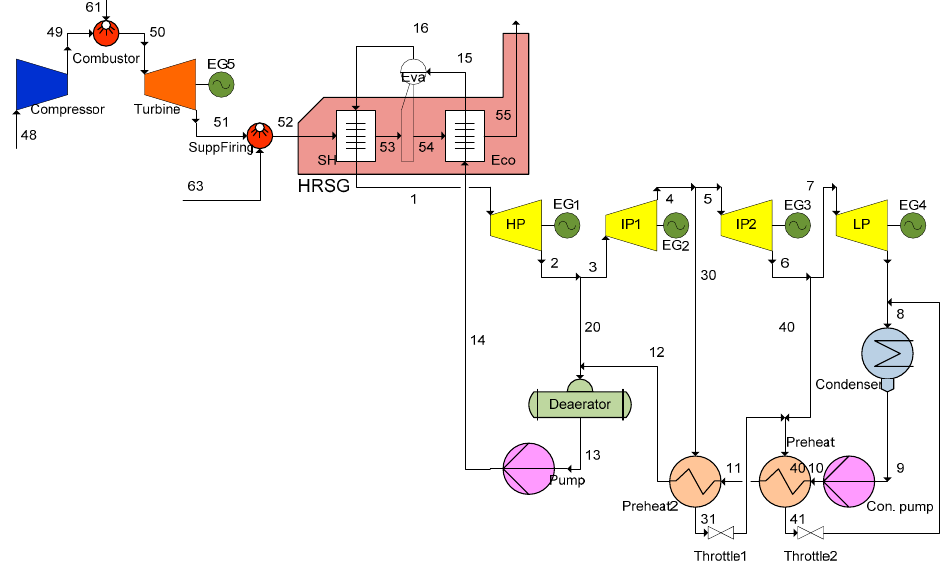
Figure 2. Natural gas fired CC plant with one GT and supplementary firing.